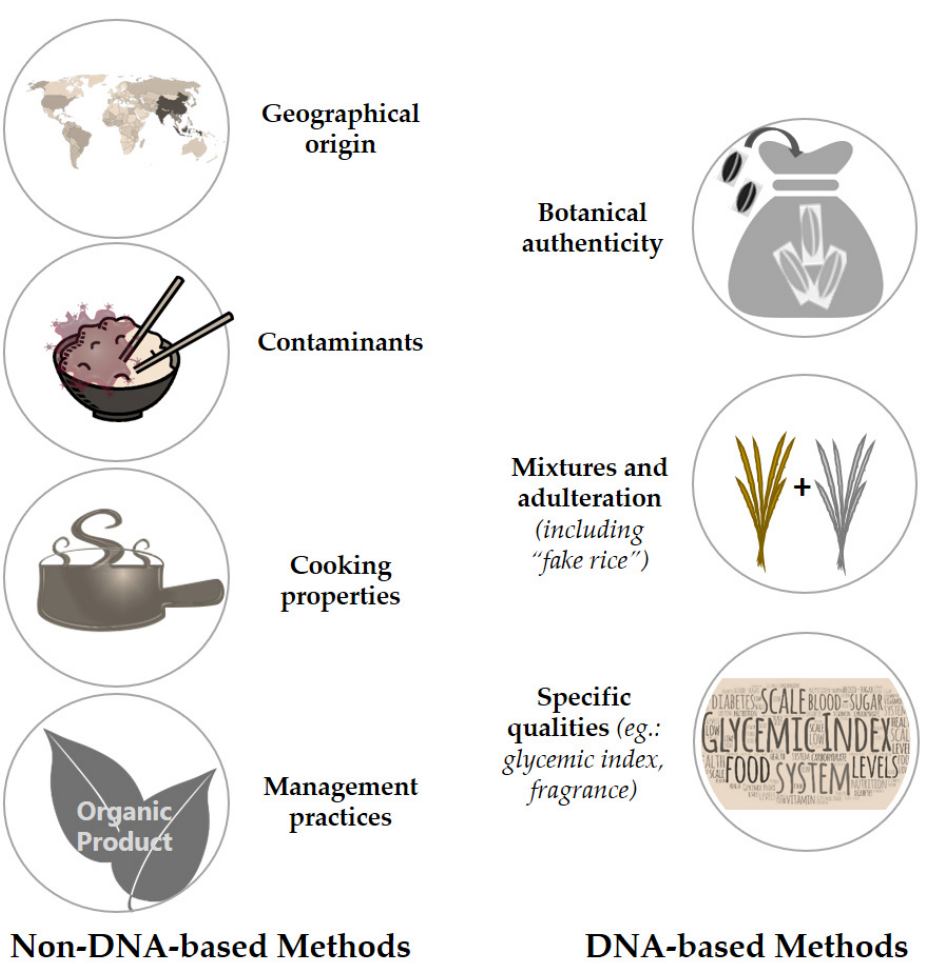
Figure 2. Schematic representation of some of the most common types of rice fraud and the preferred type of strategy (DNA or non-DNA-based) for their detection. Whenever the rice has features that result from the interaction of plant genetics and the environment (including agricultural practices, rice processing, long-term or inadequate storage, contamination with toxic compounds, pollutants etc.), DNA-based techniques are not appropriate to detect fraud, and other methods must be employed.